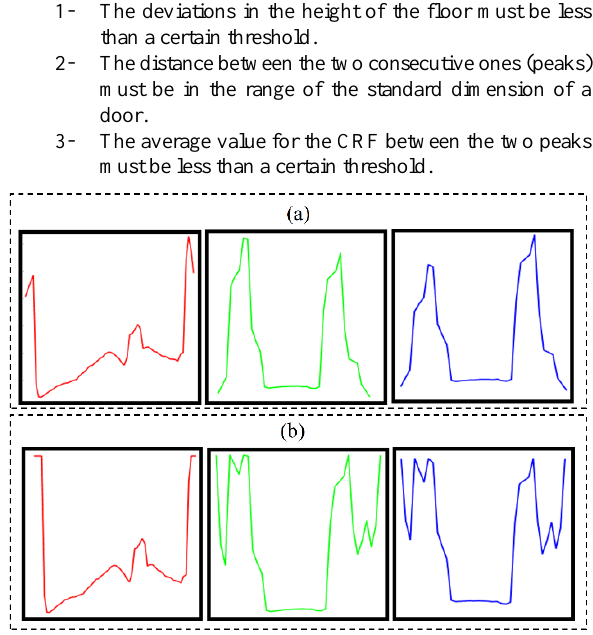
Figure 6. Approximated histograms of coordinates corresponds to a door frame. (a) DFH. (b) CRDFH.